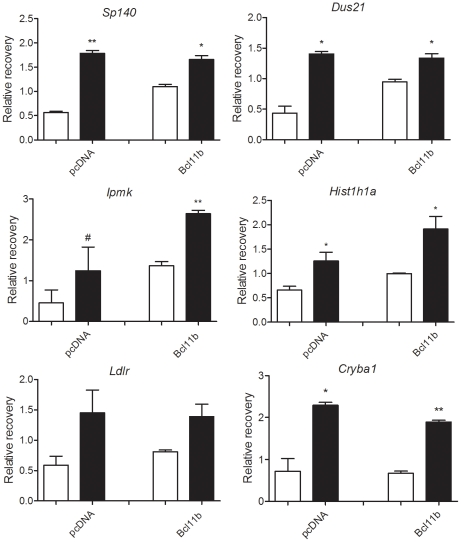
Chromatin-immunoprecipitation (ChIP)-qPCR for Bcl11b target genes.ChIP was performed using an anti-Bcl11b or control IgG antibody on both mock-transfected (pcDNA3.1) (open bars) and Bcl11b-transfected (closed bars) striatal cells as described in Methods. Real-time qPCR analysis was performed on the immunoprecipitated DNA using primers designed to amplify regulatory regions of the indicated genes.